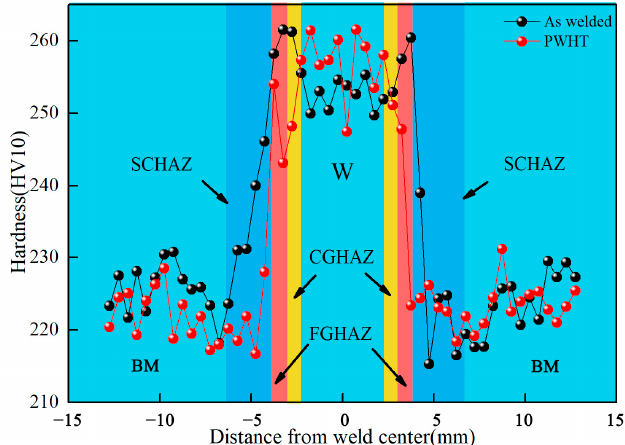
Figure 6. Hardness distribution of the welded and heat-treated joints.